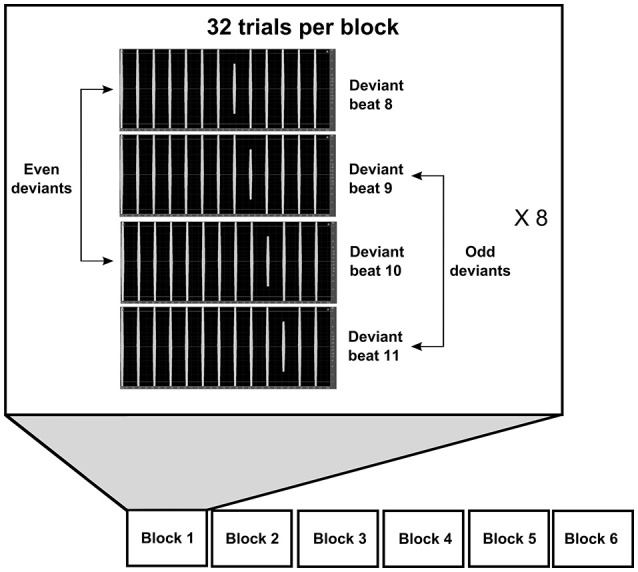
Illustration of the stimuli and paradigm. The stimuli consist of patterns of 13–16 consecutive sinus tones with even-numbered beats 8 or 10 or odd-numbered beats 9 or 11 attenuated by −4 dB. The participants listened to six blocks of stimuli, each with 32 trials.